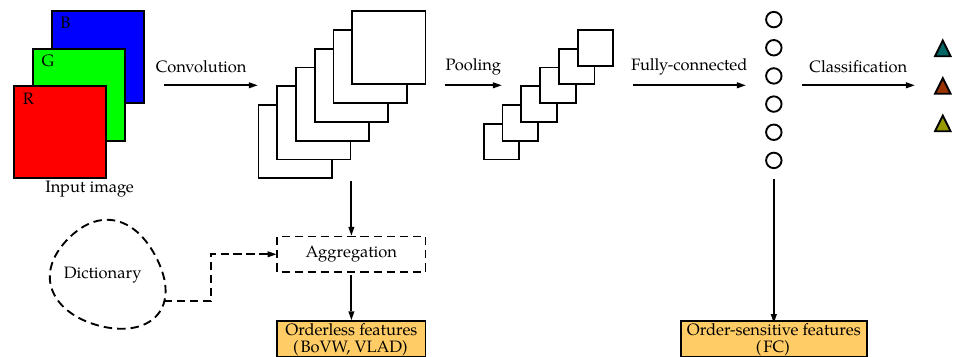
Figure 12. Simplified diagram of a generic convolutional neural network. For texture classification, we can either use the order-sensitive output of a fully-connected layer or the orderless, aggregated output of a convolutional